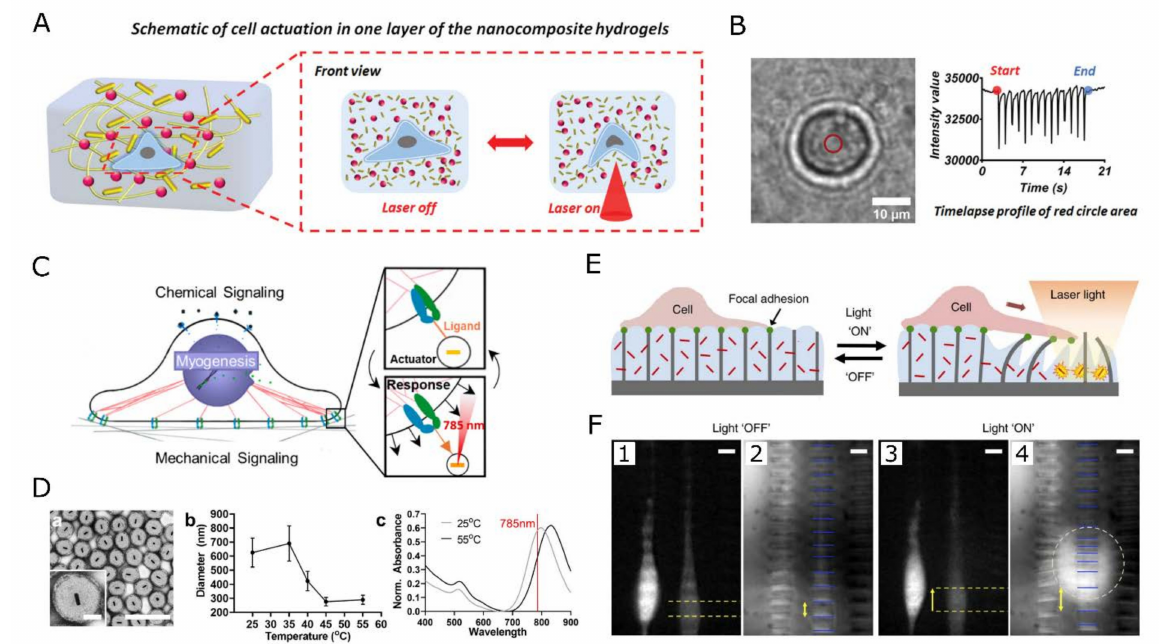
Figure 5. GNP-based optomechanical hydrogel actuation. ( A ) Illustration of a 3D GNR-PEG nanocom- posite hydrogel for cell mechanical actuation and ( B ) an encapsulated SH-SY5Y cell ‘beating’ in response to 1 Hz NIR laser stimulation. ( C ) Illustration of the operating principle of PNIPMAM- encapsulated GNRs and ( D ) TEM-image of the NPs (Scale bar 1 µ m, inset scale bar 200 nm), the hydrodynamic diameter as a function of temperature as measured by dynamic light scattering and the UV-vis-NIR absorbance spectrum at 25 ◦ C and 55 ◦ C with n red the NIR wavelength used for remote actuation. ( E ) GNR heating deforms a PNIPAM matrix exerting stress on the cell, cultured on top. The flexible nanowires embedded in the hydrogel translate the deformation into a force. ( F ) Epifluorescence images of the cells (1, 3) and brightfield images of the underlying microstructures (2, 4). The laser is focused at the center of the dashed circle that outlines the area where the hydrogel is contracted. Images (1, 2) indicate the start of the experiment, while (3, 4) are the same cells 3 s after 18 mW laser illumination. The locations of two microstructures at both timepoints are marked by the yellow dashed lines, and the elongation from 9 µ m (2) to 13 µ m (4) is indicated by the yellow arrows. Scale bars are 10 µ m. Panels ( A , B ) are reprinted with permission from Ref. [211]. Copyright 2022 Wiley. Panels ( C , D ) are reprinted with permission from Ref. [210]. Copyright 2020 American Chemical Society. Panels ( E , F) are reprinted with permission from Ref.